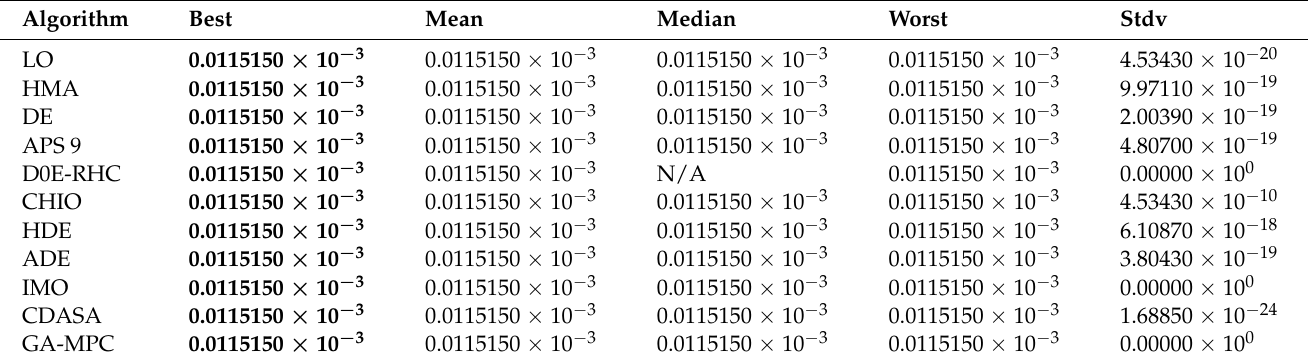
Table 9. The performance of the LO algorithm against other comparative algorithms on the bifunc- tional catalyst blend optimal control